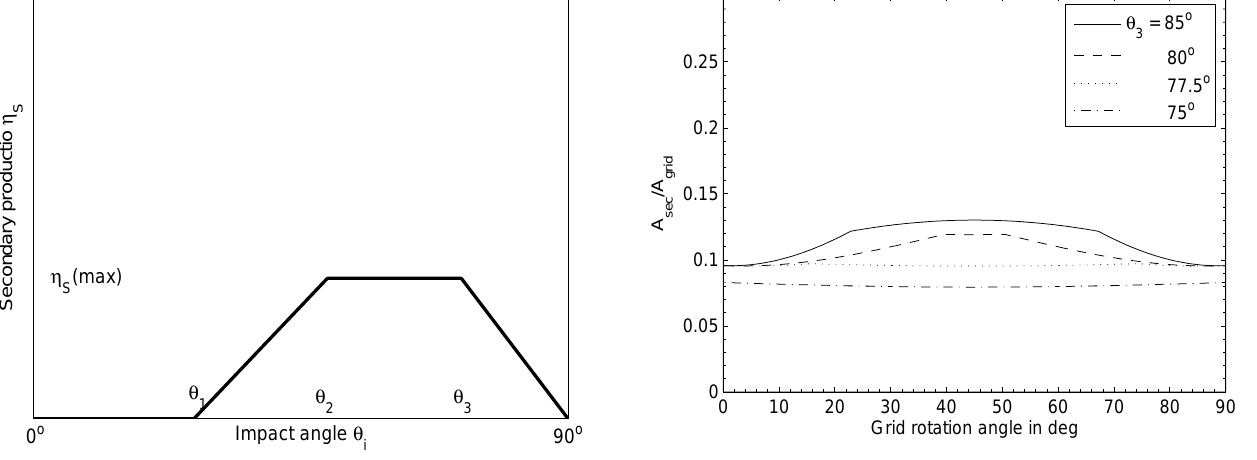
Fig. 10. A schematic representation of the secondary production of charge as a function of impact angle θ i .